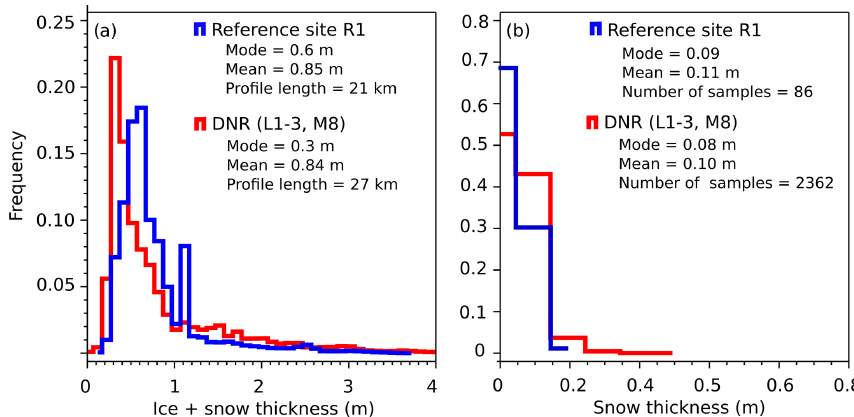
Figure 6. Total (ice plus snow, a ) and snow (b) thickness distribution of the floes located inside the DNR (L1-3, M8, red line) and at R1 (blue line; see Fig. 3a for positions). Ice thickness measurements were made with a ground-based electromagnetic (GEM) instrument pulled across the ice on a sledge. Snow thickness measurements were made with a